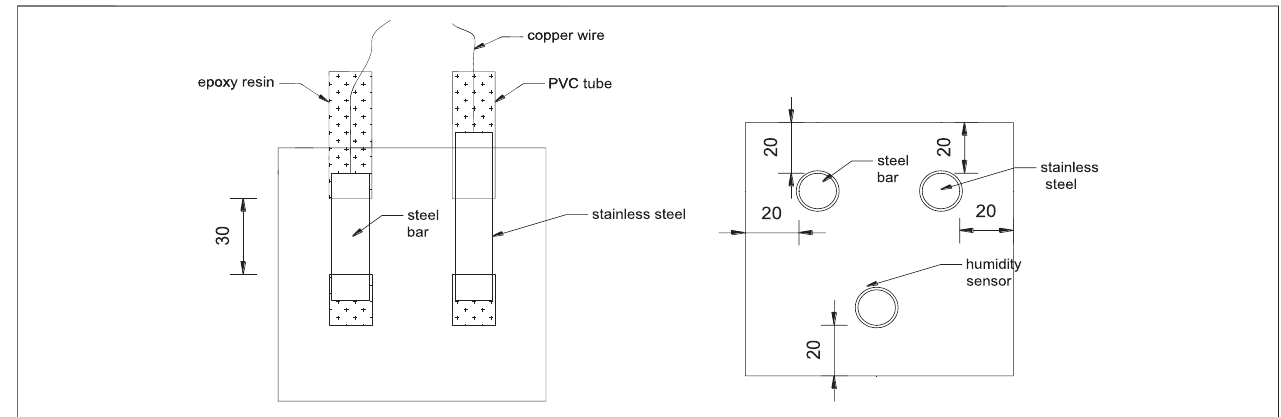
FIGURE 6 | Electrochemical test